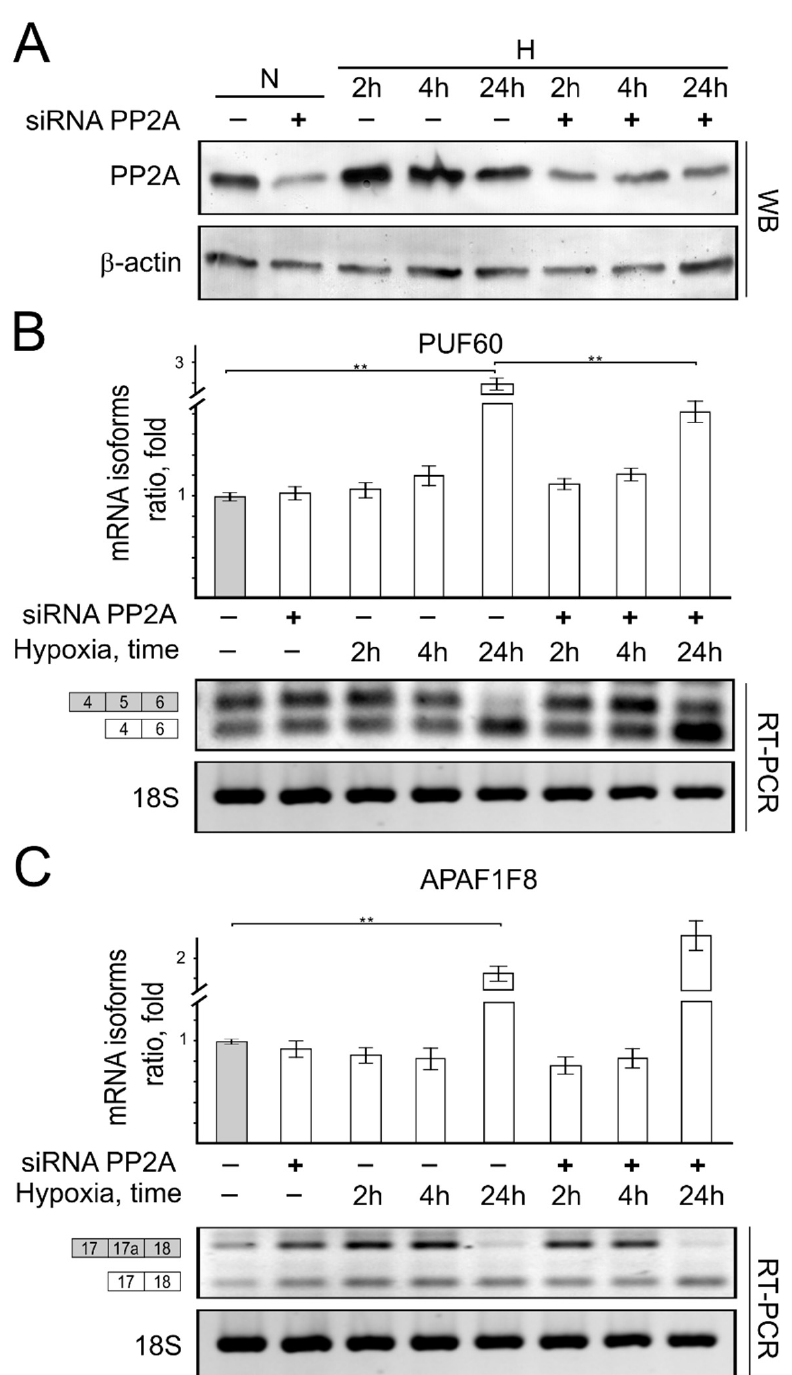
Figure 8. The role of PP2A protein expression for PUF60 and APAF1F8 splicing in normoxic and hypoxic HCT116 cells. Western blot showing PP2A ( A ) protein expression levels in normoxic and hypoxic cells. Reverse transcription PCR (RT-PCR) results showing PUF60 and APAF1F8 genes and alternative mRNA isoform expression ratios in reduced PP2A ( B , C ) protein levels expressing normoxic and hypoxic HCT116 cells. Bar plot represents the quantification of endogenous protein expression of 3 independent experiments when protein expression in cells grown under normal oxygen conditions is taken as 1. Error bars represent the amount of spread between the extremes of the data, ** p < 0.05. N—cells cultivated under normal conditions; H—cells cultivated under hypoxic conditions for indicated time (2 h, 4 h, and 24 h).